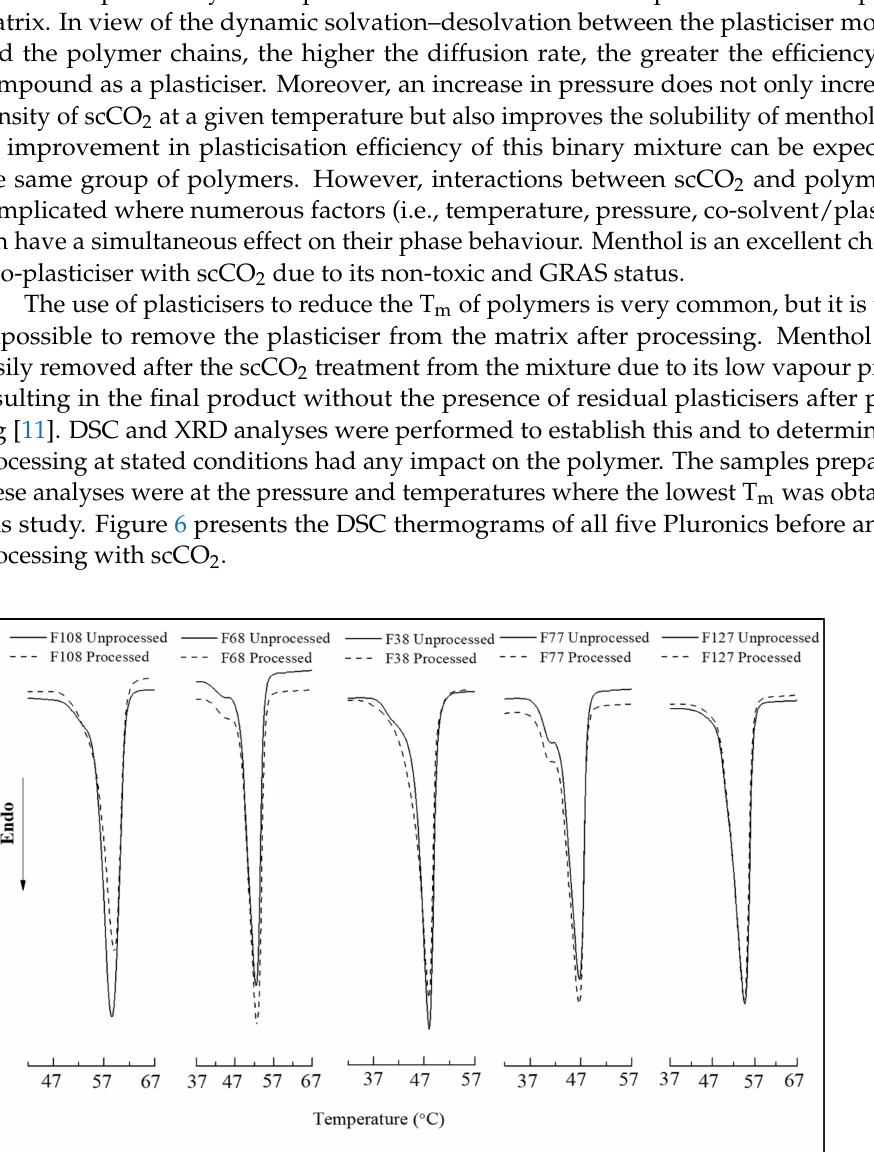
XRD diffractograms of the processed and unprocessed samples of polymers are pre- sented in Figure